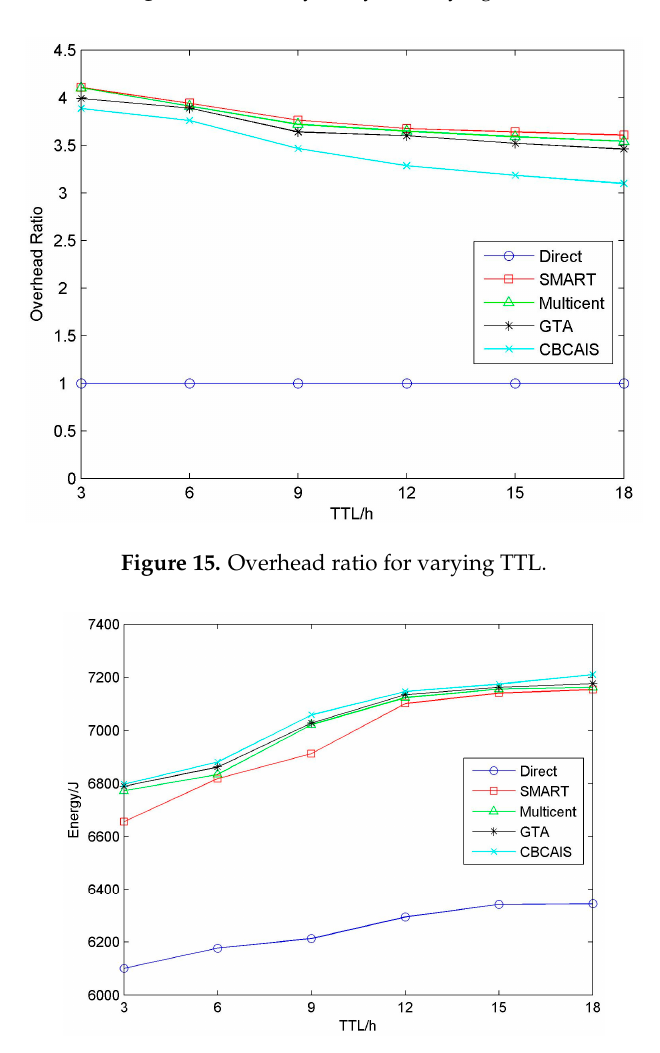
Figure 14. Delivery delay for varying TTL.